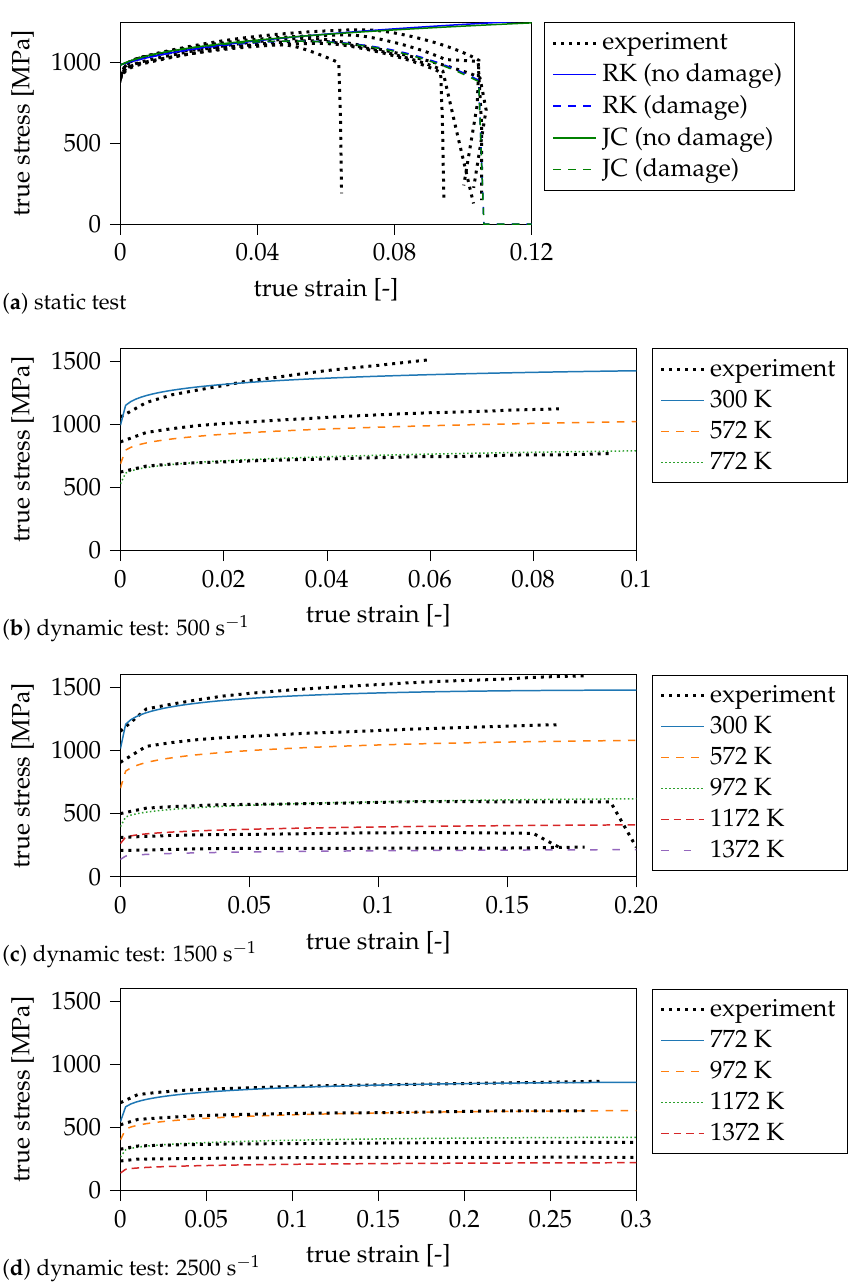
Figure 2. Material calibration: the red dotted lines show the experimental results. ( a ) fit of static constants for the JC and RK model with damage (dashed lines) and without damage (solid lines); ( b – d ) fit of dynamic parameters (JC model) for different strain rates (500 s − 1 to 2500 s − 1 ) with data of Lee and Yeh for temperatures between 300 K and 1372 K